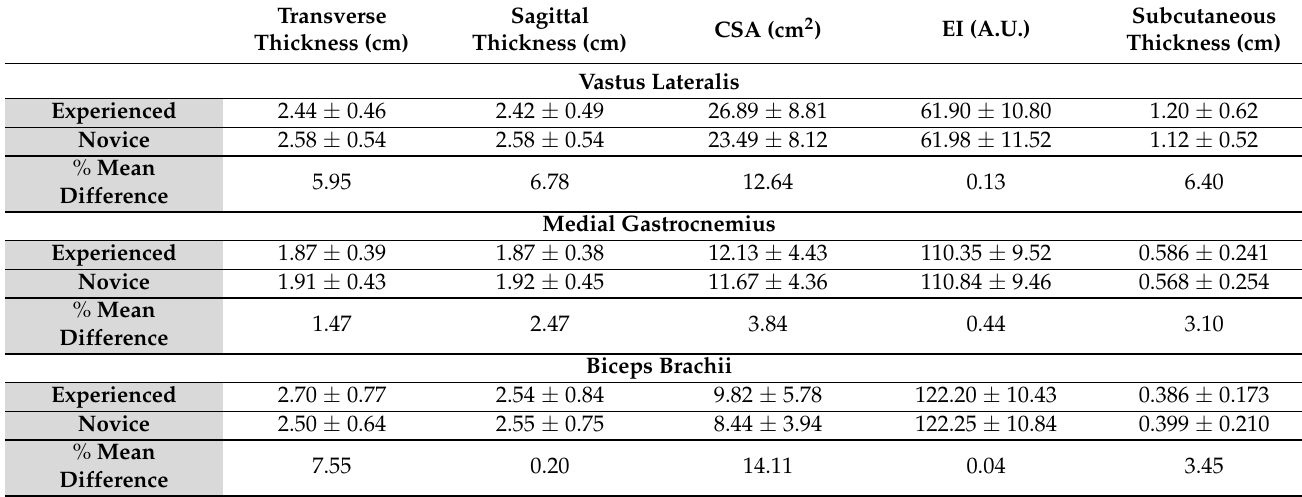
Table 3. Mean ± SD values and the % mean difference between the experienced and novice image analysts for each muscle and